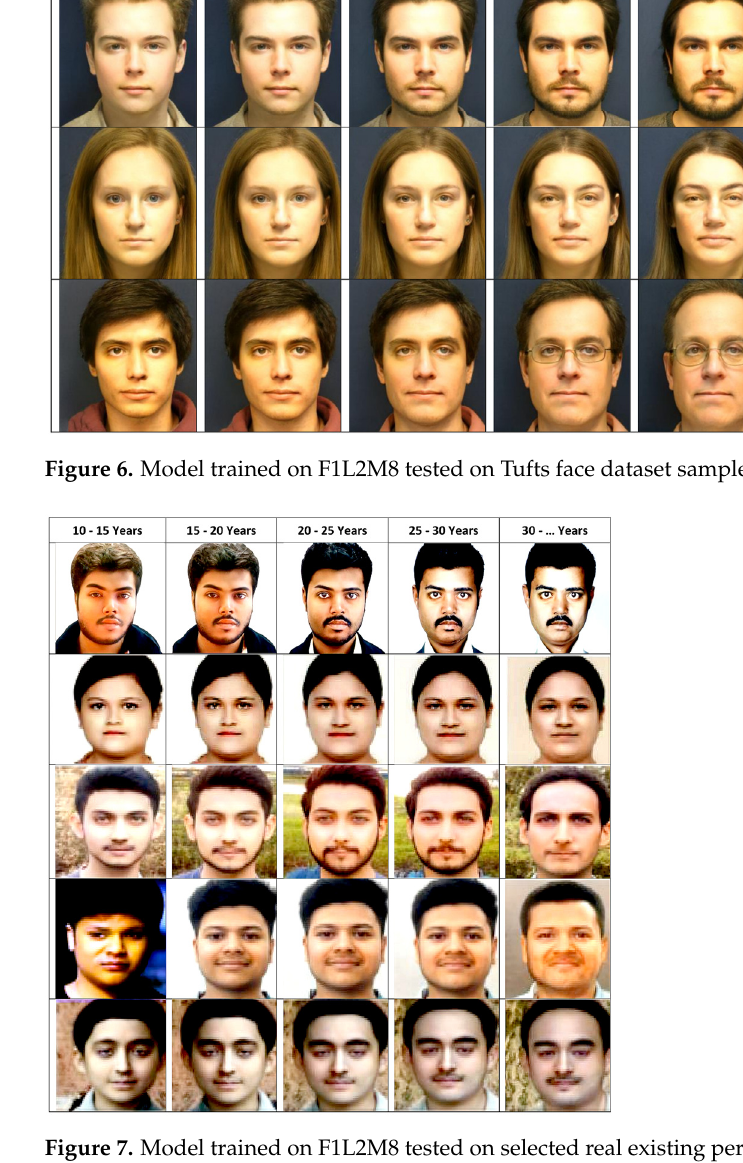
Table 4. Comparison of the proposed work with related models.